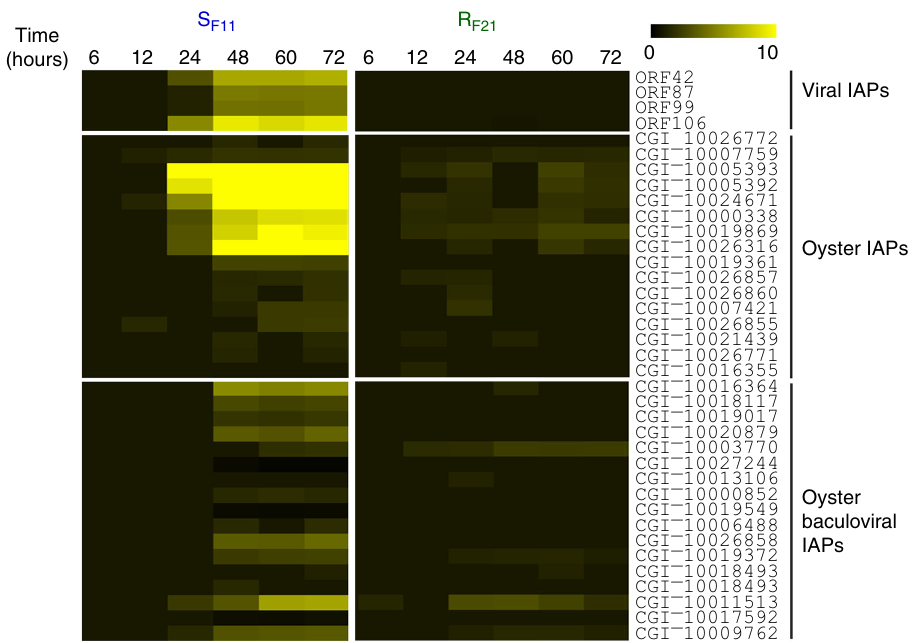
Fig. 6 Viral and oyster endogenous inhibitors of apoptosis (IAPs) are strongly induced in the susceptible S F11 oysters (but not in the resistant R F21 oysters) during the ‘ natural ’ experimental infection. The fold changes in virus IAPs, oyster IAPs, and oyster and baculoviral IAPs were calculated between each time point of the kinetics and the T0. Analyses were conducted with the RNA-seq data through mapping against the C . gigas genome for oyster IAPs and against the OsHV-1 genome for viral IAPs 30 . The intensity of the colour indicates the magnitude of the differential expression (log2 fold change). The heatmap was constructed with Multiple Array Viewer